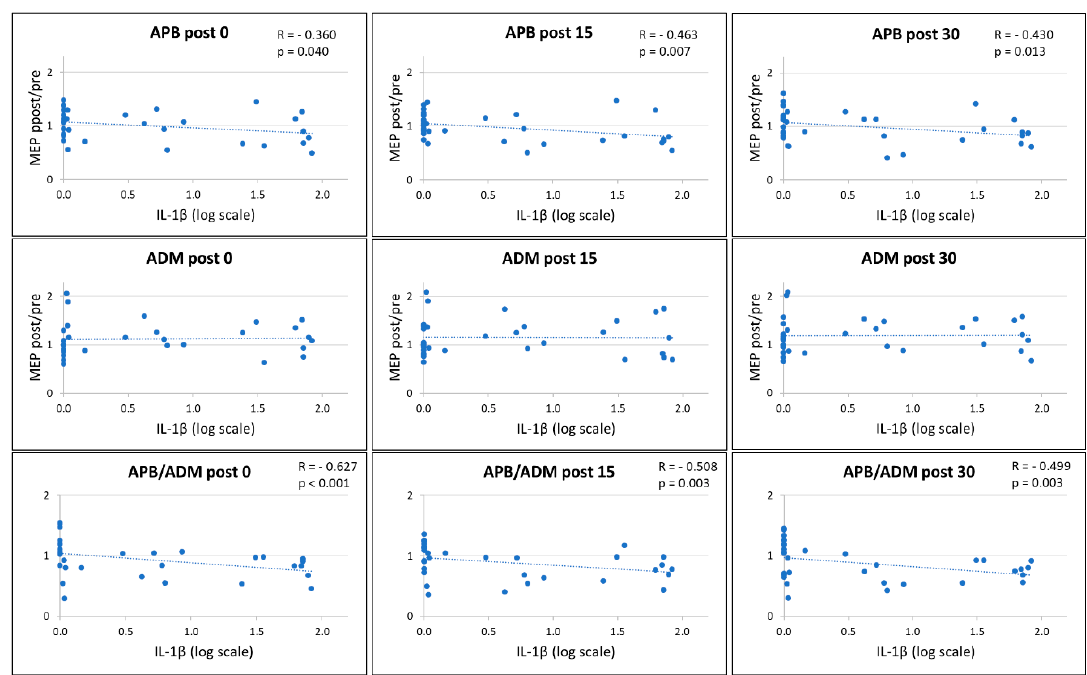
Figure 2. Correlation between IL-1 β CSF Levels and PAS E ff ects. Figure 2 legend. A negative correlation was found between IL-1 β CSF concentrations and LTP-like e ff ects in the APB muscle at post 0, post 15, and post 30 ( upper panels ); conversely, no significant correlation emerged with LTP-like e ff ects in the ADM muscle ( middle panels ). A significant negative correlation was found between IL-1 β CSF levels and the ratio of the LTP-like e ff ect induced in APB and ADM muscles ( lower panels ). Abbreviations: APB (abductor pollicis brevis); ADM (abductor digiti minimi); CSF (cerebrospinal fluid); IL (interleukin); MEP (motor-evoked potential).